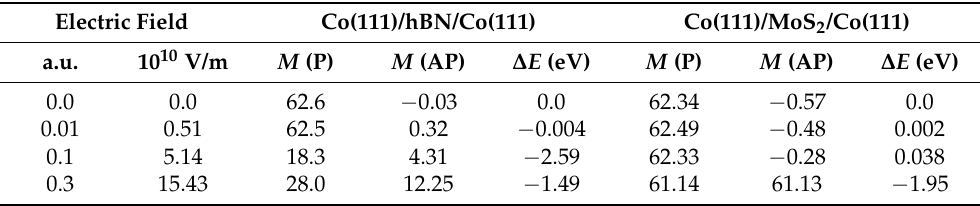
Table 1. Field effects on the magnetization energy ( ∆ E ), magnetization ( M ) per cell (in Bohr magneton) for spin aligned parallel (P), and antiparallel (AP) to the quantization